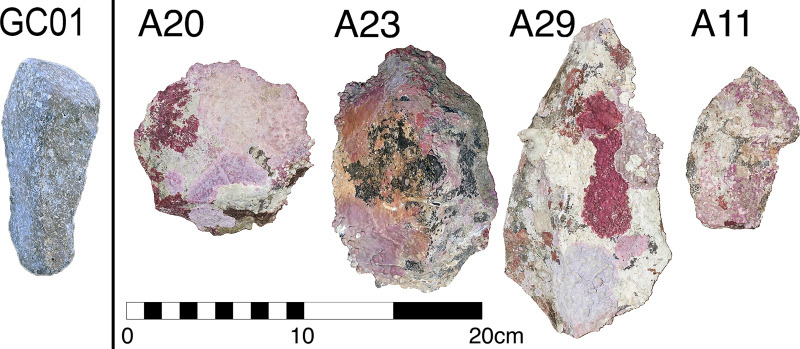
Artefacts recovered under water from Cape Bruguieres (A20, A23, A29 and A11) have well-preserved, acute edges showing no signs of rolling.This is in contrast to material where clear repeated transport and motion has resulted in rolled edges and a lack of marine growth, demonstrated by a possible (but inconclusive) artefact from Goodwyn Island cave (GC01).